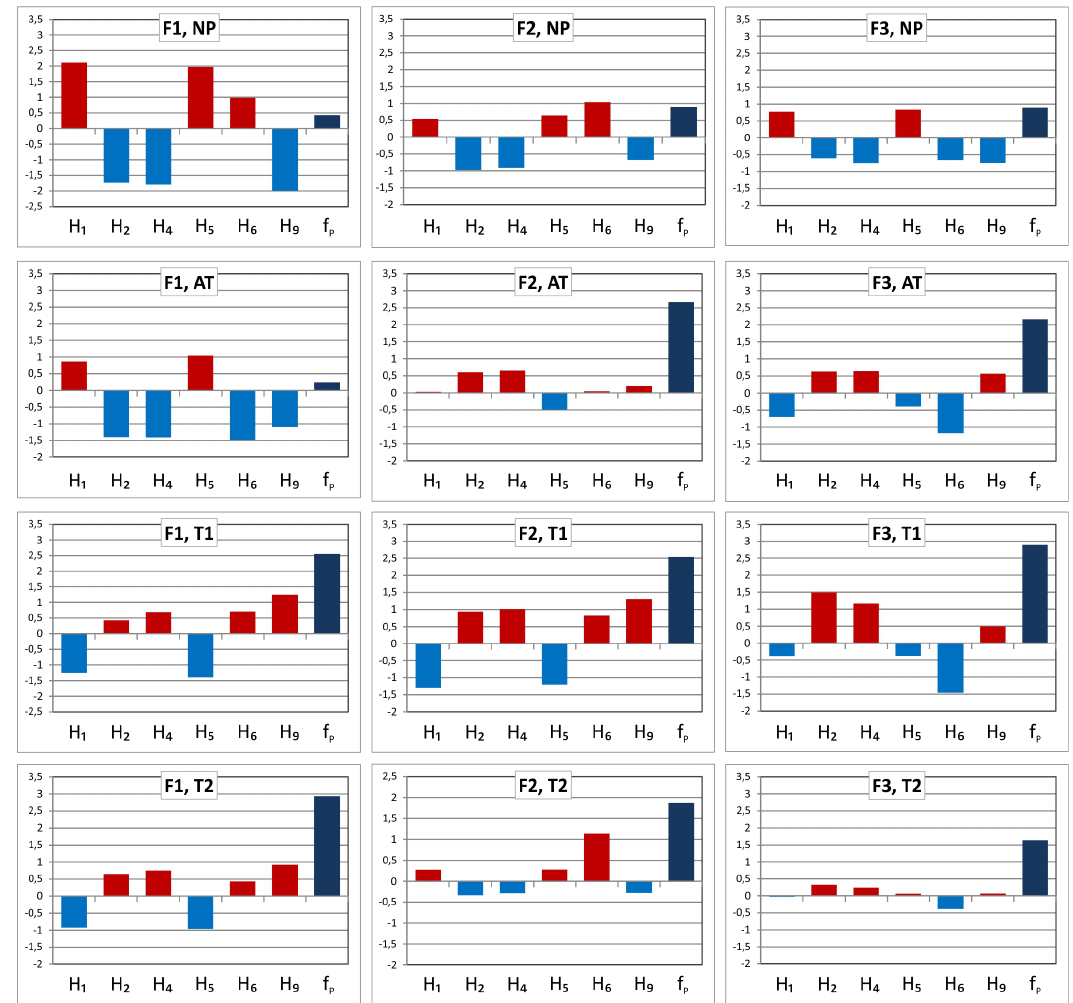
Figure 8. Selected texture feature variability due to fabric abrasion: F 1, F 2, F 3—types of fabric tested; H 1 ( energy ) , H 2 ( contrast ) , H 4 ( variance ) , H 5 ( homogeneity ) , H 6 ( sum average ) , H 9 ( entropy ) —Haralick feature types; f P —fraction of fiber pixels; NP —not pilled (control) sample; T 1, T 2—manual tests; AT —apparatus